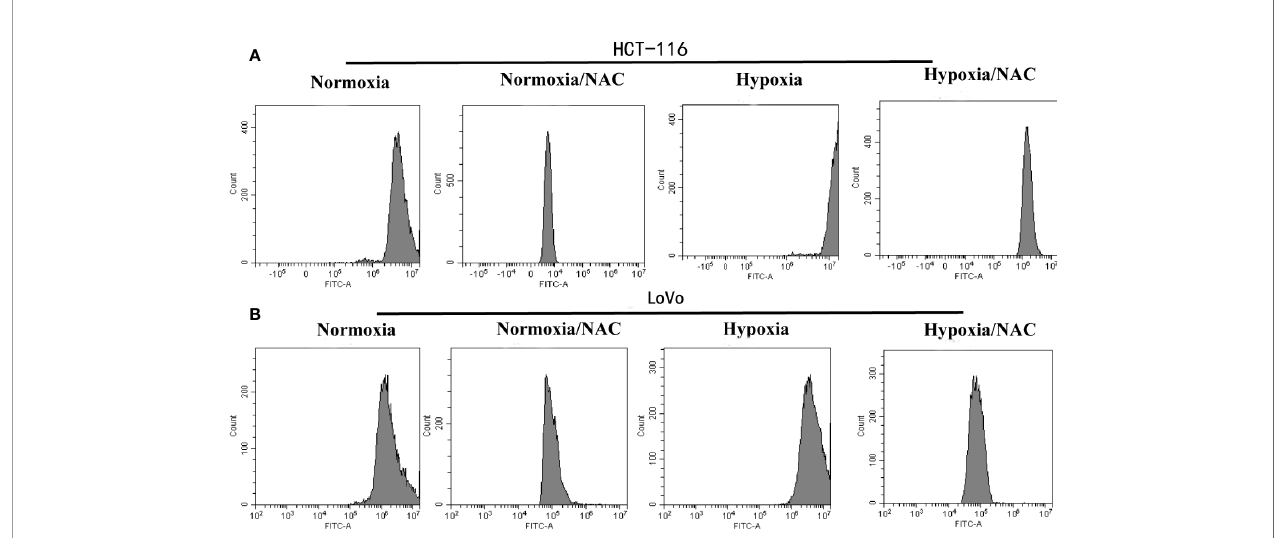
FIGURE 3 | Hypoxia increases the ROS level in colorectal cancer cells and NAC could reverse this phenomenon. The (A) HCT-116 and (B) LoVo cells were cultured in hypoxic condition (1% O 2 ) and treated with NAC for 24 h, then treated with DCFH-DA (10 m M) for 30 min; the DCF fl uorescence intensity was measured by fl ow